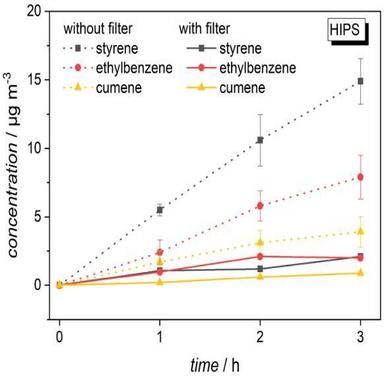
Changes of VOCs concentration in 250 L close chamber with operating 3D printer without any filtration (dashed line) or with irradiated Sb/ g-C3N4 photocatalyst (solid line). Error bars based on the 3 measurements.